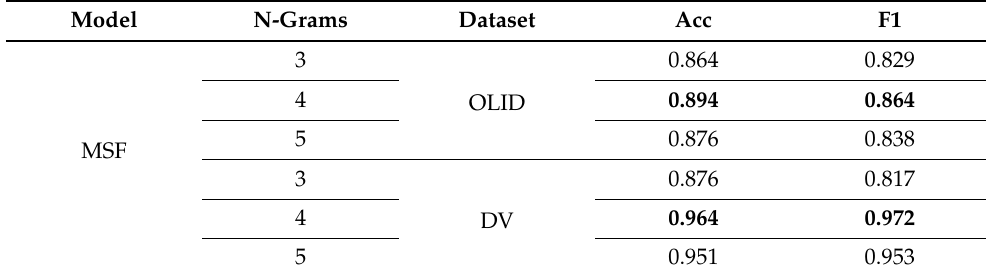
Table 4. Effect of different values of